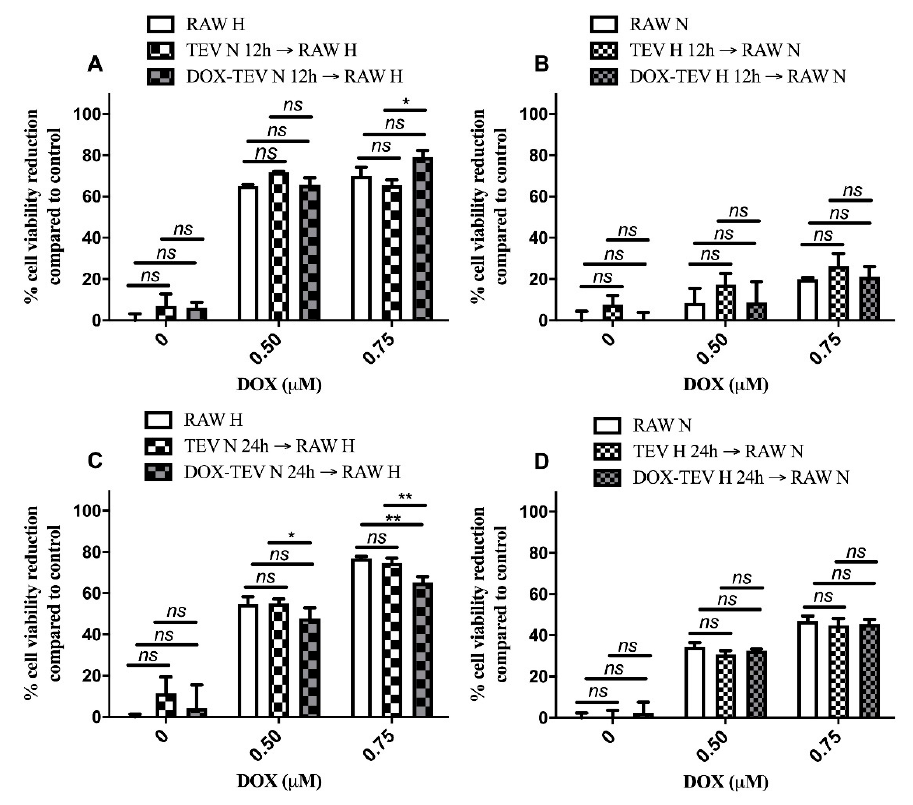
Figure 5. Cell viability of RAW 264.7 cells cultured under normoxia and hypoxia after pretreatment with EVs from C26 cells and exposure to DOX treatment. The effects of TEV secreted by untreated normoxic C26 cells (TEV N) or by 0.3 µM DOX-treated normoxic cells (DOX-TEV N) on hypoxic RAW 264.7 cells (RAW H) treated with different DOX concentrations for 12 h are shown in panel ( A ) and for 24 h are shown in panel ( C ). The effects of TEV secreted by untreated hypoxic C26 cells (TEV H) or by 0.3 µM DOX-treated hypoxic cells (DOX-TEV H) on normoxic RAW 264.7 cells (RAW N) treated with different DOX concentrations for 12 h are shown in panel ( B ) and for 24 h are shown in panel ( D ). Data from interexperimental duplicates are represented as mean ± SD and expressed as percentages compared to the corresponding controls (untreated RAW 264.7 cells, RAW 264.7 cells treated with 0.5 µM DOX that were not pretreated with TEV, and RAW 264.7 cells treated with 0.75 µM DOX that were not pretreated with TEV, respectively); ns : not significant, p > 0.05; *, p < 0.05; **, p < 0.01.